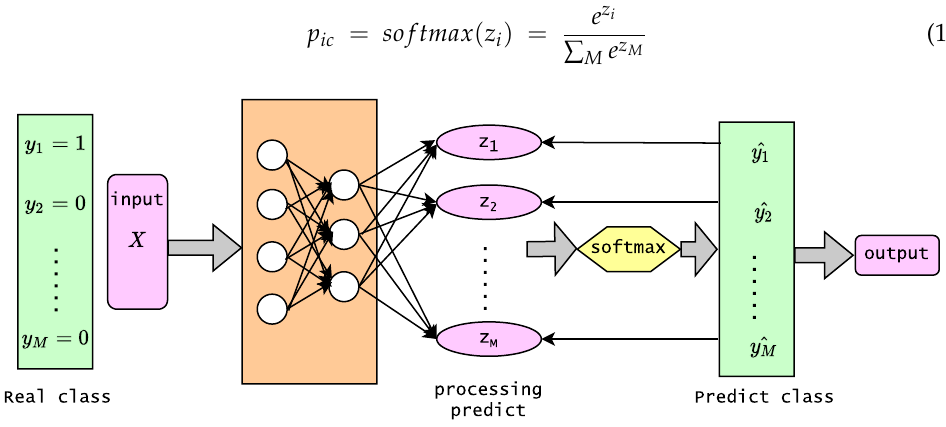
Figure 3. Calculation process of cross-entropy(CE) loss